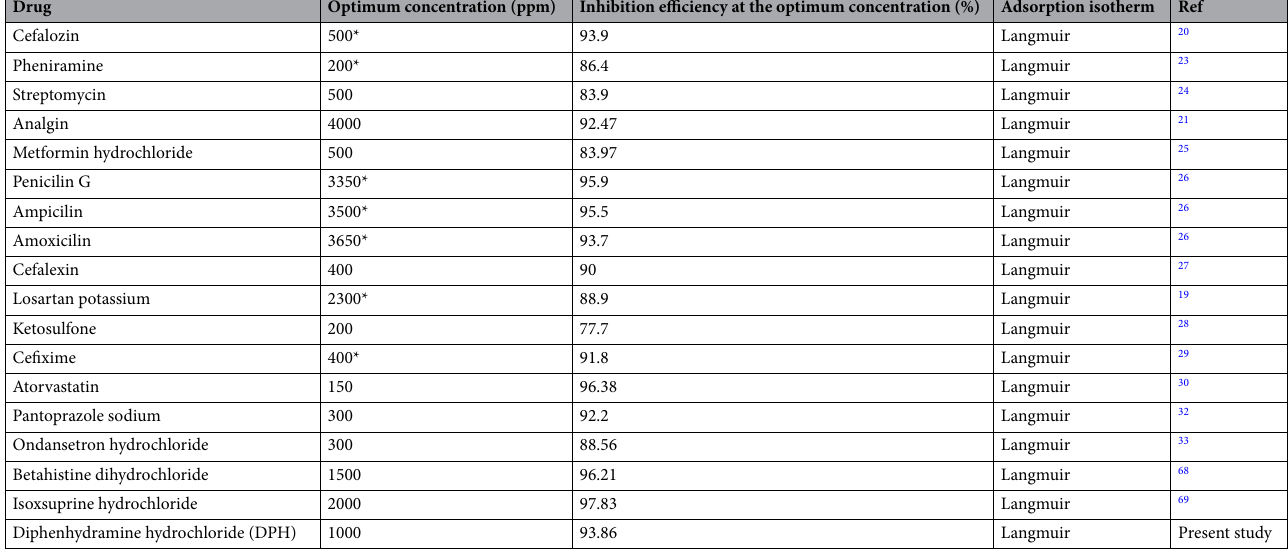
Table 5. Comparison of corrosion inhibition efficiency and adsorption isotherm of different drugs in 1 M HCl medium. *The concentration of these compounds is converted from mM to